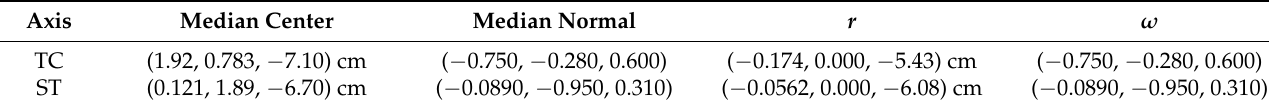
Table 8. Axis estimation data.